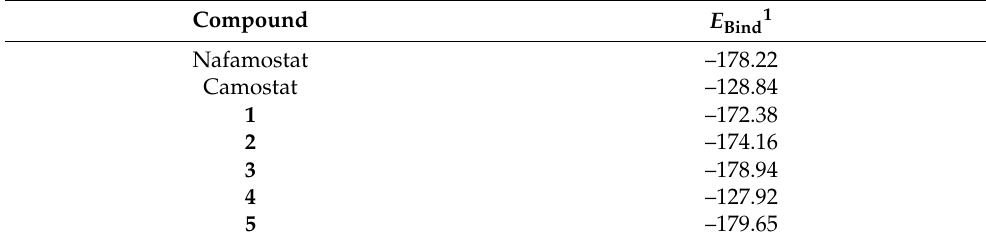
Table 1. TMPRSS2-ligand binding energies